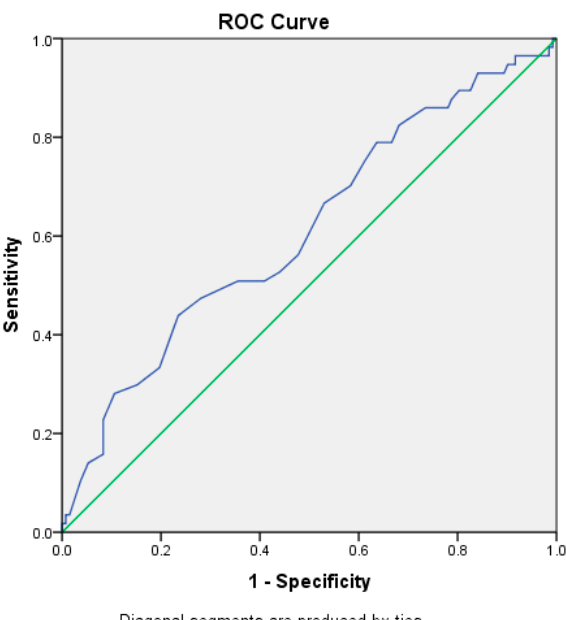
Figure 3. ROC curve analysis of ADP HS for the prediction of dyspnea. AUC = 0.612, 95% CI = 0.523– 0.701, p = 0.015. ADP HS cut-off value = 19.5; sensitivity = 43.9%, specificity = 76.5%. Youden